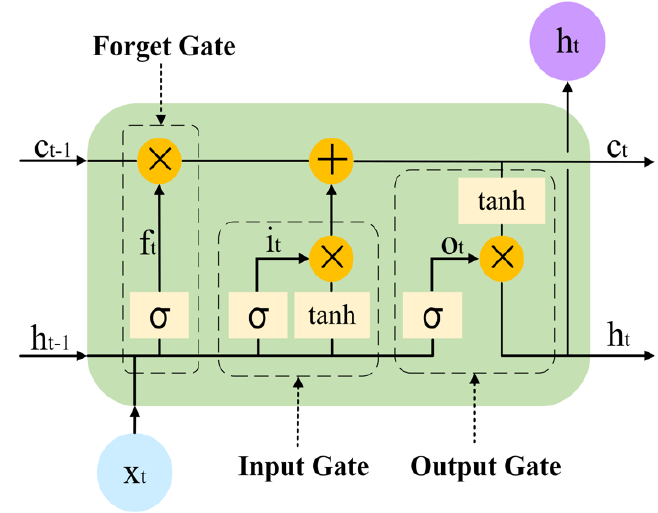
Figure 2. Schematic diagram of neurons.